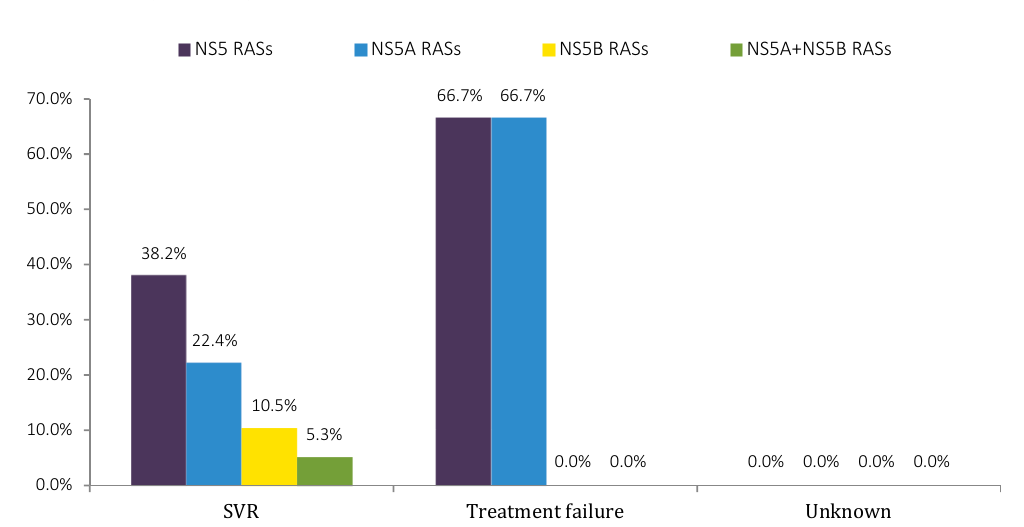
Figure 4. Percentage of HCV infected patients with NS5 RASs, according to treatment outcome status. Substitution analyses were conducted on Sanger sequencing data with a 15% cut-off limit. Dual-class RASs are assigned as NS5A + NS5B RASs.